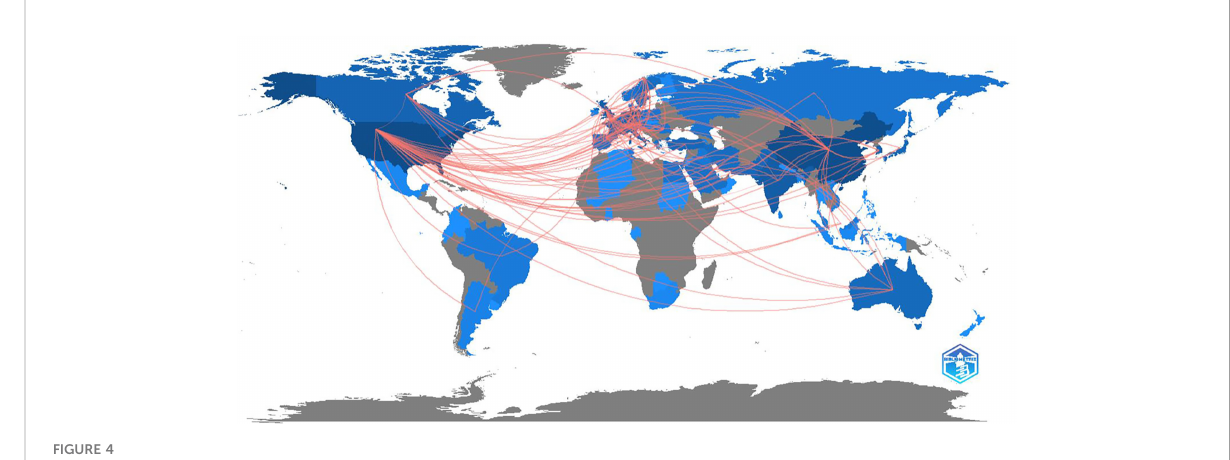
FIGURE 4 The collaboration network on world map.